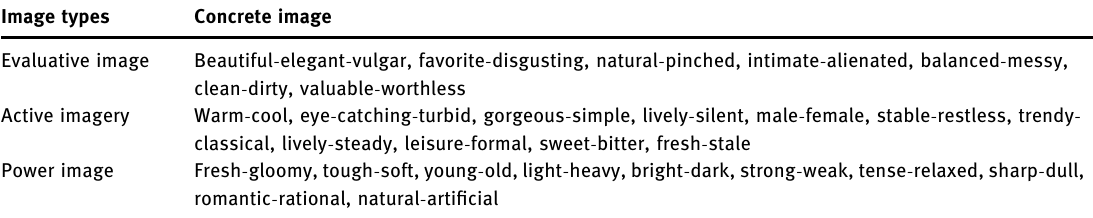
Table 2: Image conveyed by emotional information of oil painting color Image